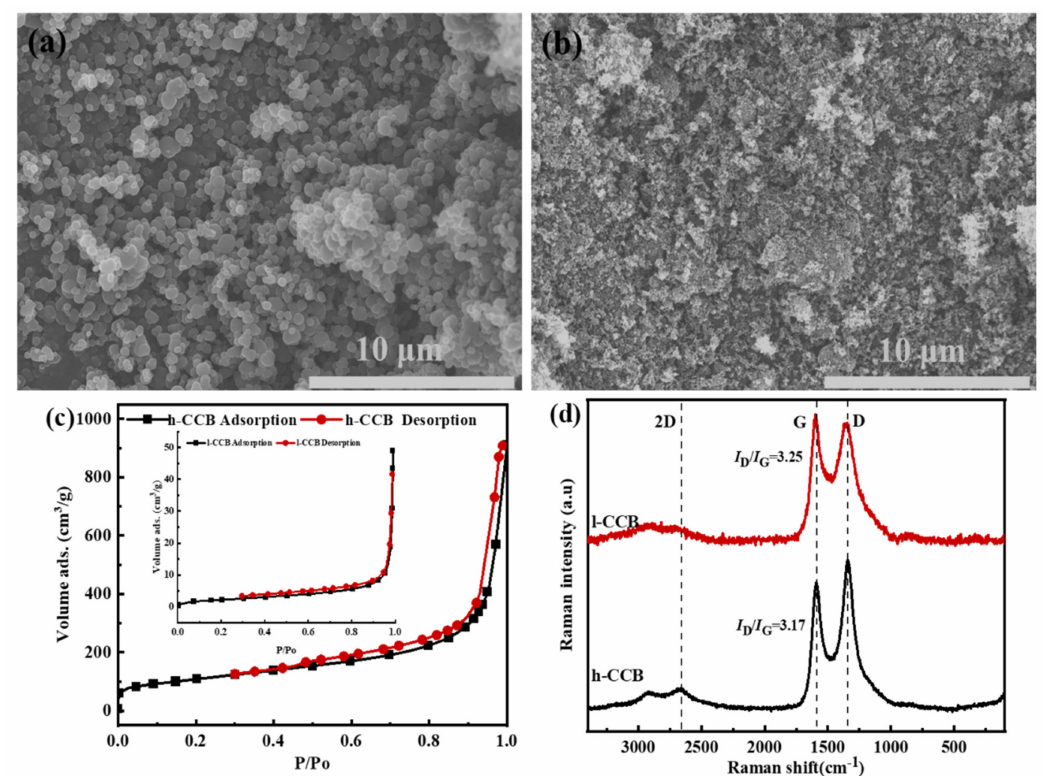
Figure 2. SEM images of CCB particles: ( a ) l-CCB particle; ( b ) h-CCB particles; ( c ) N 2 adsorption/desorption isotherms, ( d ) Raman spectroscopy of nanoscale h-CCB and l-CCB